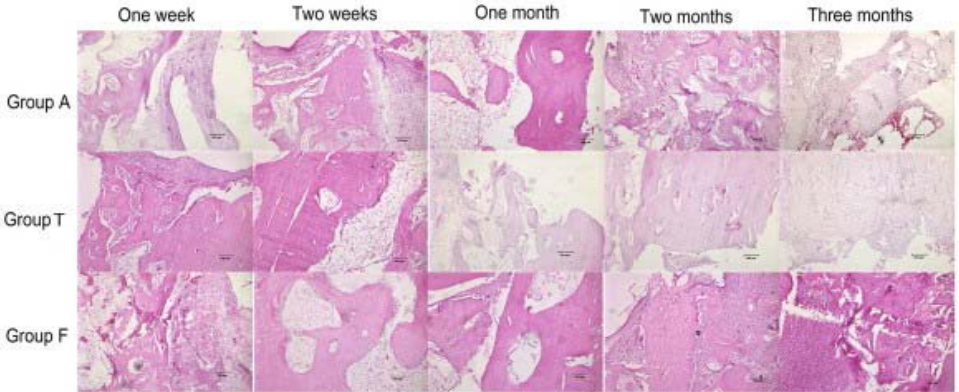
Figure 2. Hematoxylin and eosin (HE) stained sections imaging around the implants made of (A) uncoated AZ31 Mg alloy screw, (T) Ti alloy screw, and (F) AZ31 Mg alloy coated with fluorine, with different intervals. Reprinted with permission from Ref. [30]. Copyright 2016, Elsevier.